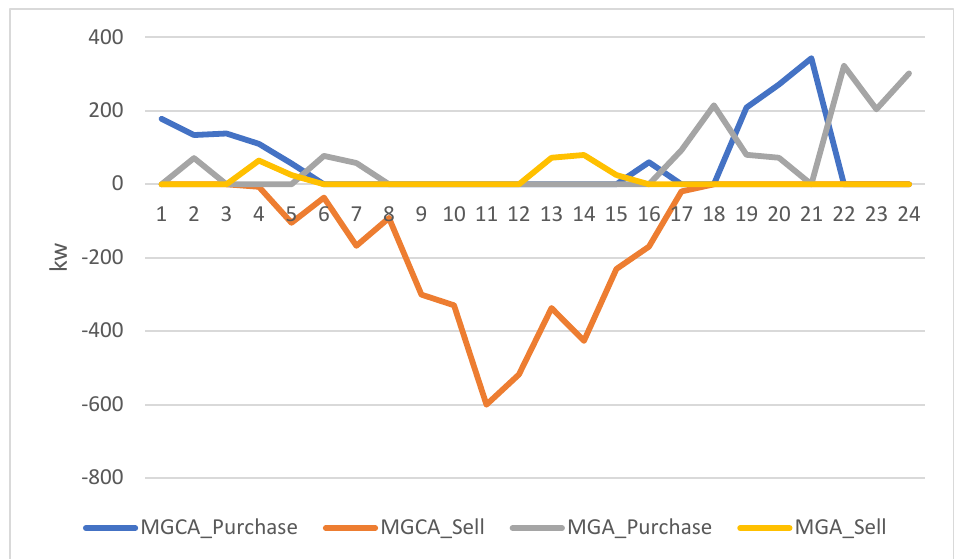
Figure 17. Variations in power bought and sold from the microgrid cluster to microgrids and the upstream network.